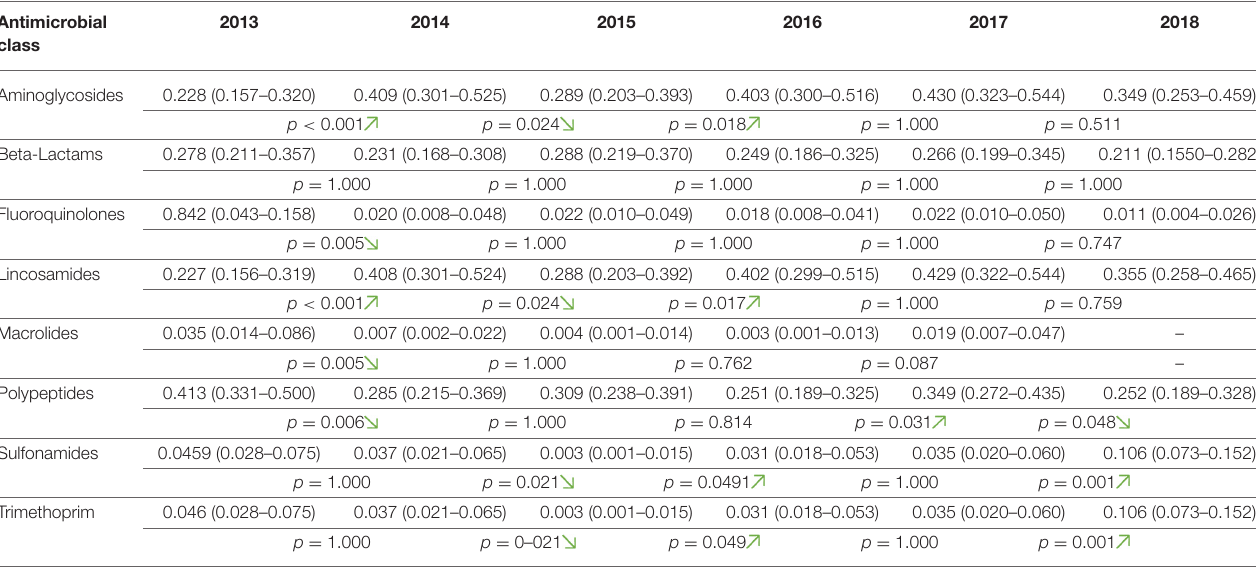
TABLE 4 | Estimated proportion of the AMU per antimicrobial class; estimated least square means with confidence interval; pairwise comparison of the usage between consecutive years. Antimicrobial